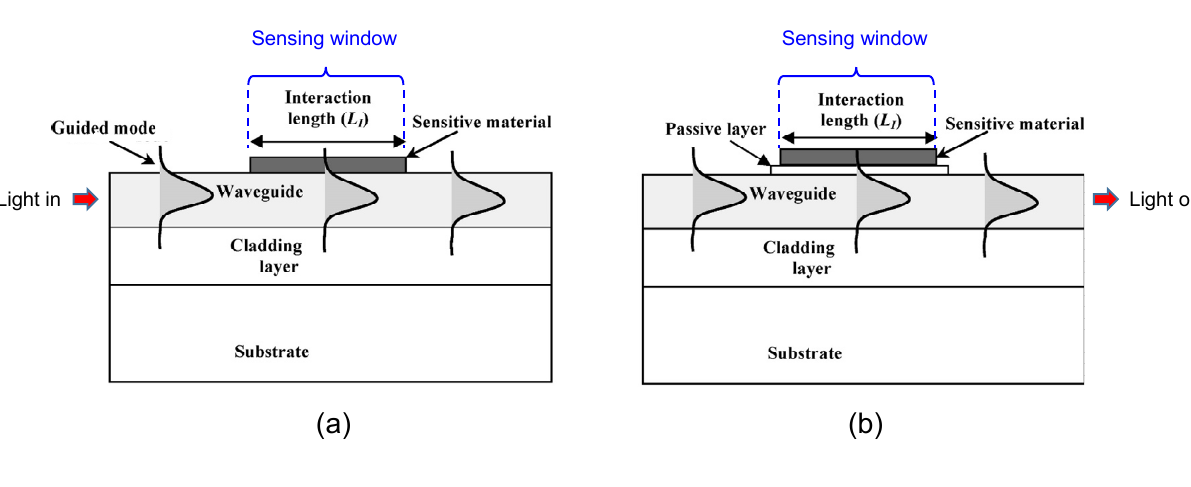
Figure 9. Schematic structures of the two types of waveguide sensors: ( a ) conventional waveguide sensor; ( b ) multilayer integrated waveguide sensor. With permission from [60]; Copyright 2008, American Chemical